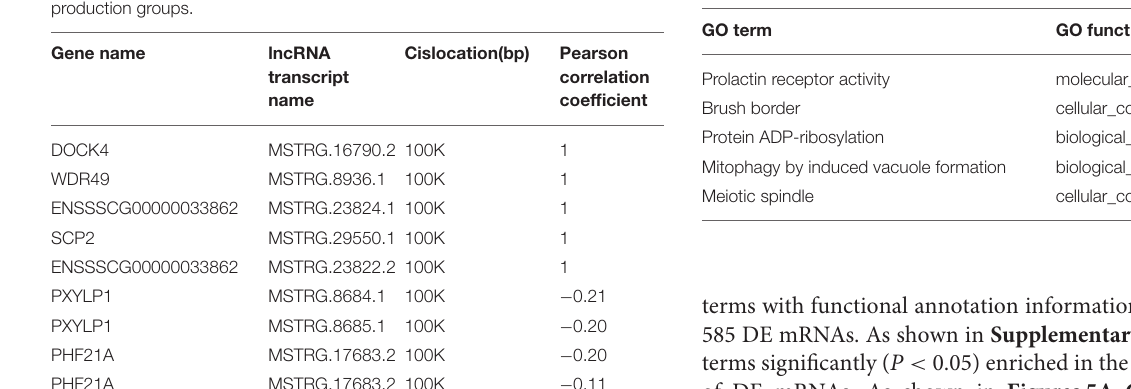
TABLE 2 | Co-enriched GO terms of DE lncRNA and DE